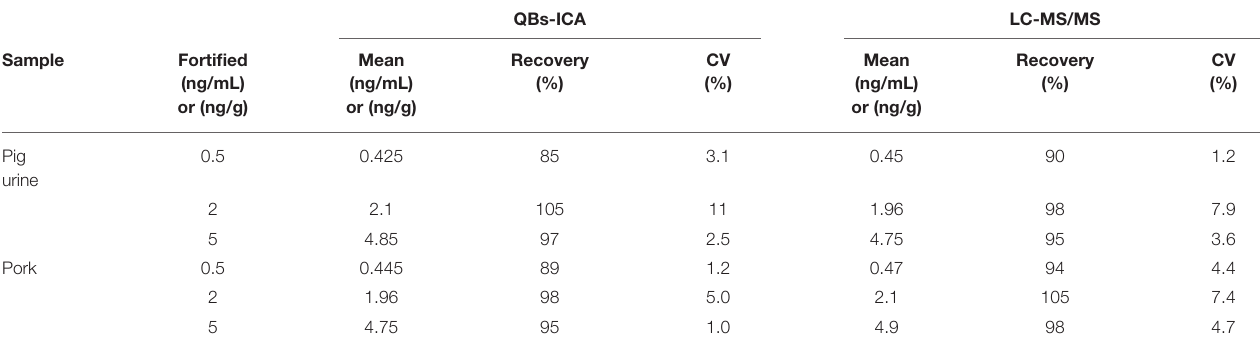
TABLE 3 | Results of QBs-ICA and LC-MS/MS for spiked samples (pig urine and pork).